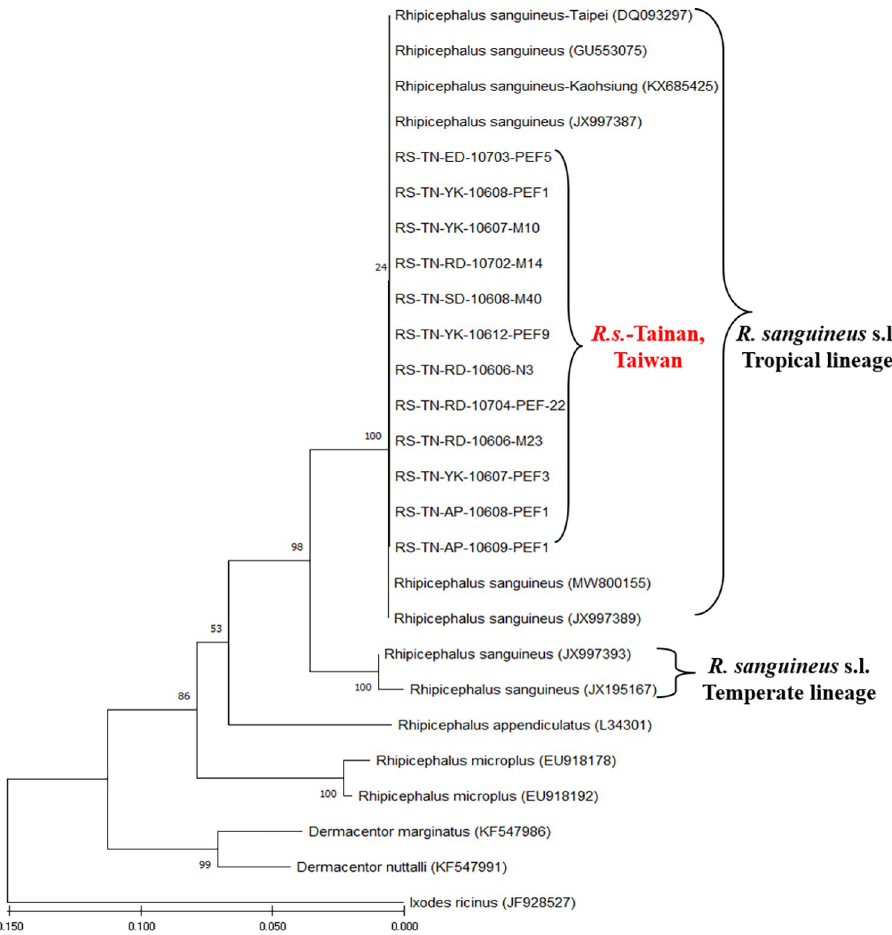
Fig 5. Phylogenetic relationships of Rh . sanguineus ticks of Tainan based on mitochondrial 16S rRNA gene. Sequences of 12 specimens of Rh . sanguineus ticks of Tainan were analyzed with 14 other strains of Rhipicephalus , Dermacentor and Ixodes ticks. The tree was constructed and analyzed by neighbour-joining (NJ) method using 1000 bootstraps replicates. Numbers at the nodes indicate the percentages of reliability of each branch of the tree. Branch length is drawn proportional to the estimated sequence